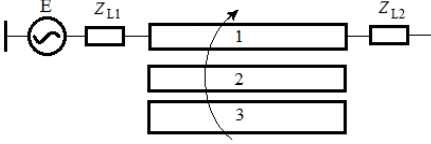
Fig. 2. Section of split strip line with inserted strip 3 having strong electromagnetic coupling with strips 1 and 2 .